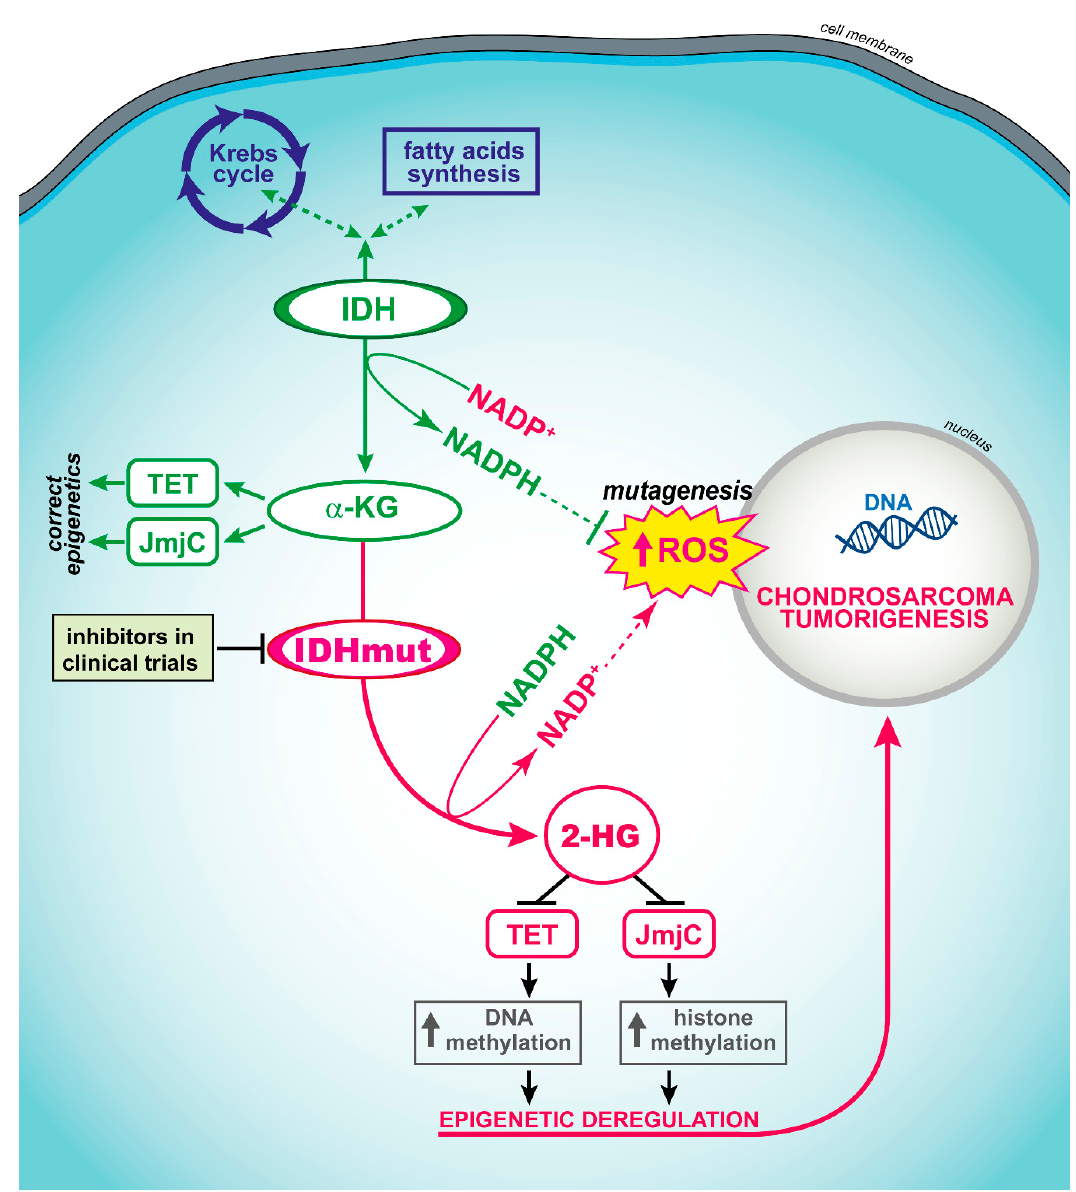
Figure 2. Role of isocitrate dehydrogenase (IDH) and IDH-mutated forms on the inhibition of demethylation pathways and its possible impact on chondrosarcoma genesis. Instead of isocitrate being converted to α -ketoglutarate ( α -KG) with the production of reduced nicotinamide adenine dinucleotide phosphate (NADPH), α -KG is converted to 2-hydroxyglutarate (2-HG) with the consumption of reduced nicotinamide adenine dinucleotide phosphate NADPH. 2-HG is expressed at high levels in tumor cells and supports tumorigenesis by modulating Jumonji-C (JmjC)-mediated histone methylation and Tet methylcytosine dioxygenase TET-mediated DNA methylation. ROS, reactive oxygen species.